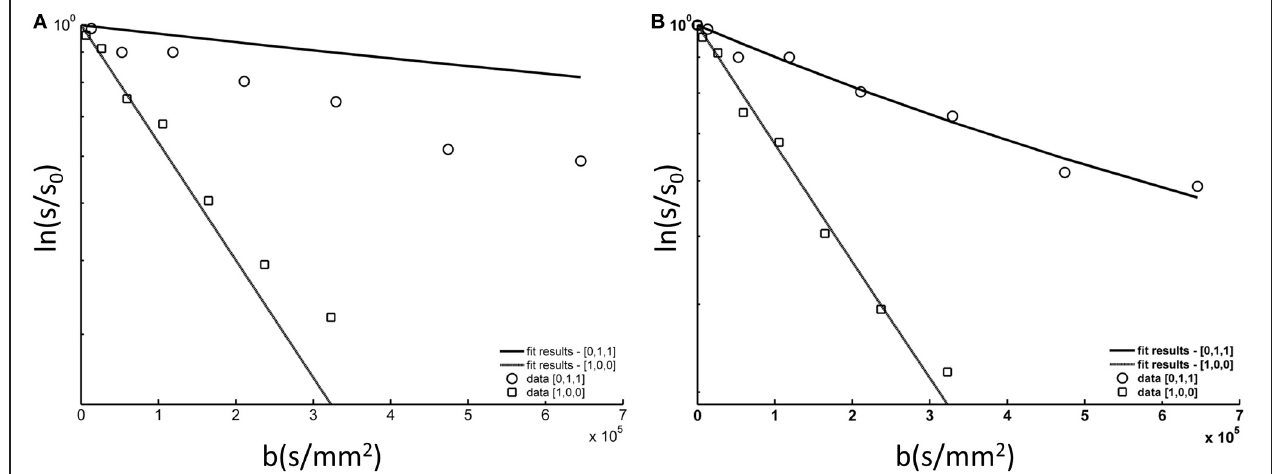
σ ψ = 10 . 0 ◦ ; (B) the data fitted to the model with two fitting variables, D(tNAA), and σ ψ . In this case D(tNAA) = 0 . 43 × 10 − 3 mm 2 /s and σ ψ = 22 . 3 ◦